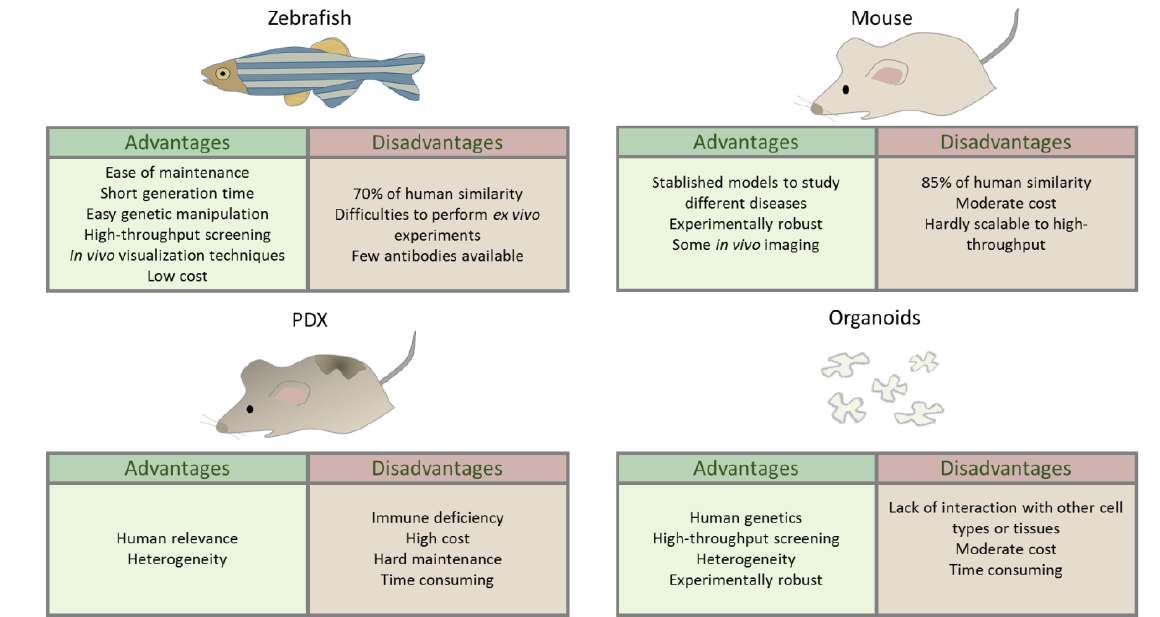
Figure 1. Advantages and disadvantages of zebrafish model compared with mouse, patient-derived xenograft (PDX), and human organoid models.